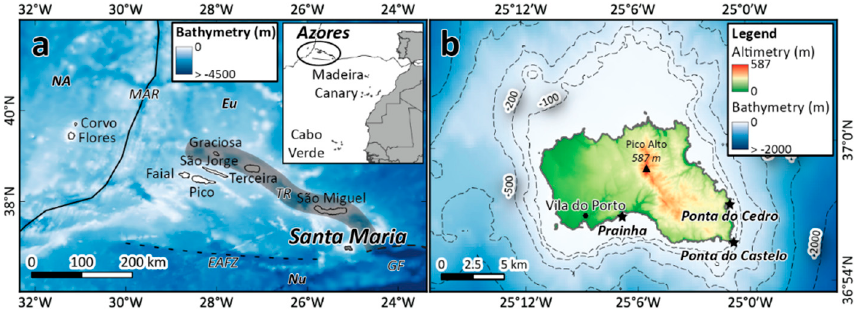
Figure 1. Maps covering the Azores Archipelago in the NE Atlantic Ocean: ( a ) Geographic and geotectonic setting of the Azores Archipelago (modified from [26–28]). NA—North American plate; Eu—Eurasian plate; Nu—Nubian (African) plate; MAR – Mid Atlantic Ridge; TR—Terceira Rift (grey area); EAFZ—East Azores Fracture Zone; GF—Gloria Fault; ( b ) Topography / bathymetry of Santa Maria Island. Black stars mark the studied sites. The bathymetric data was extracted from GEBCO 2019 (https: // www.gebco.net); subaerial topography was generated from a 1:5000 scale digital altimetric database.